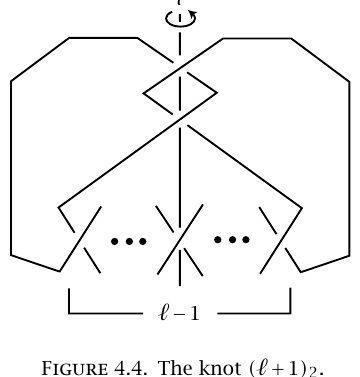
Figure 4.4 . The knot ((cid:2) + 1 ) 2